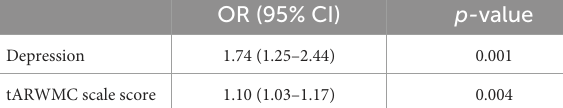
TABLE 4 Variables associated with CI at follow-up; multivariate logistic regression analysis adjusted for age and vascular risk factors. OR (95%